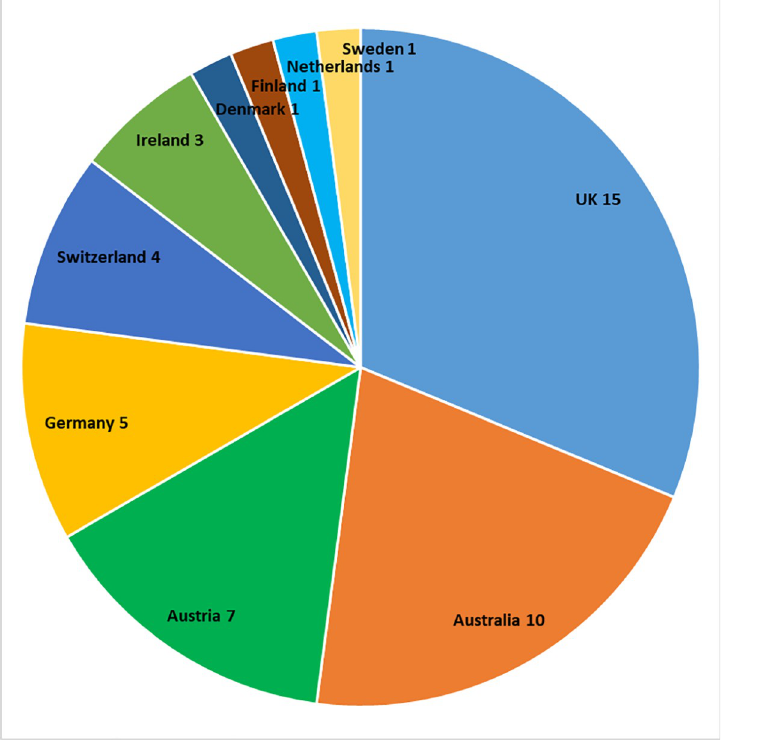
Fig 1. Number of BDCS projects in each country (total number: